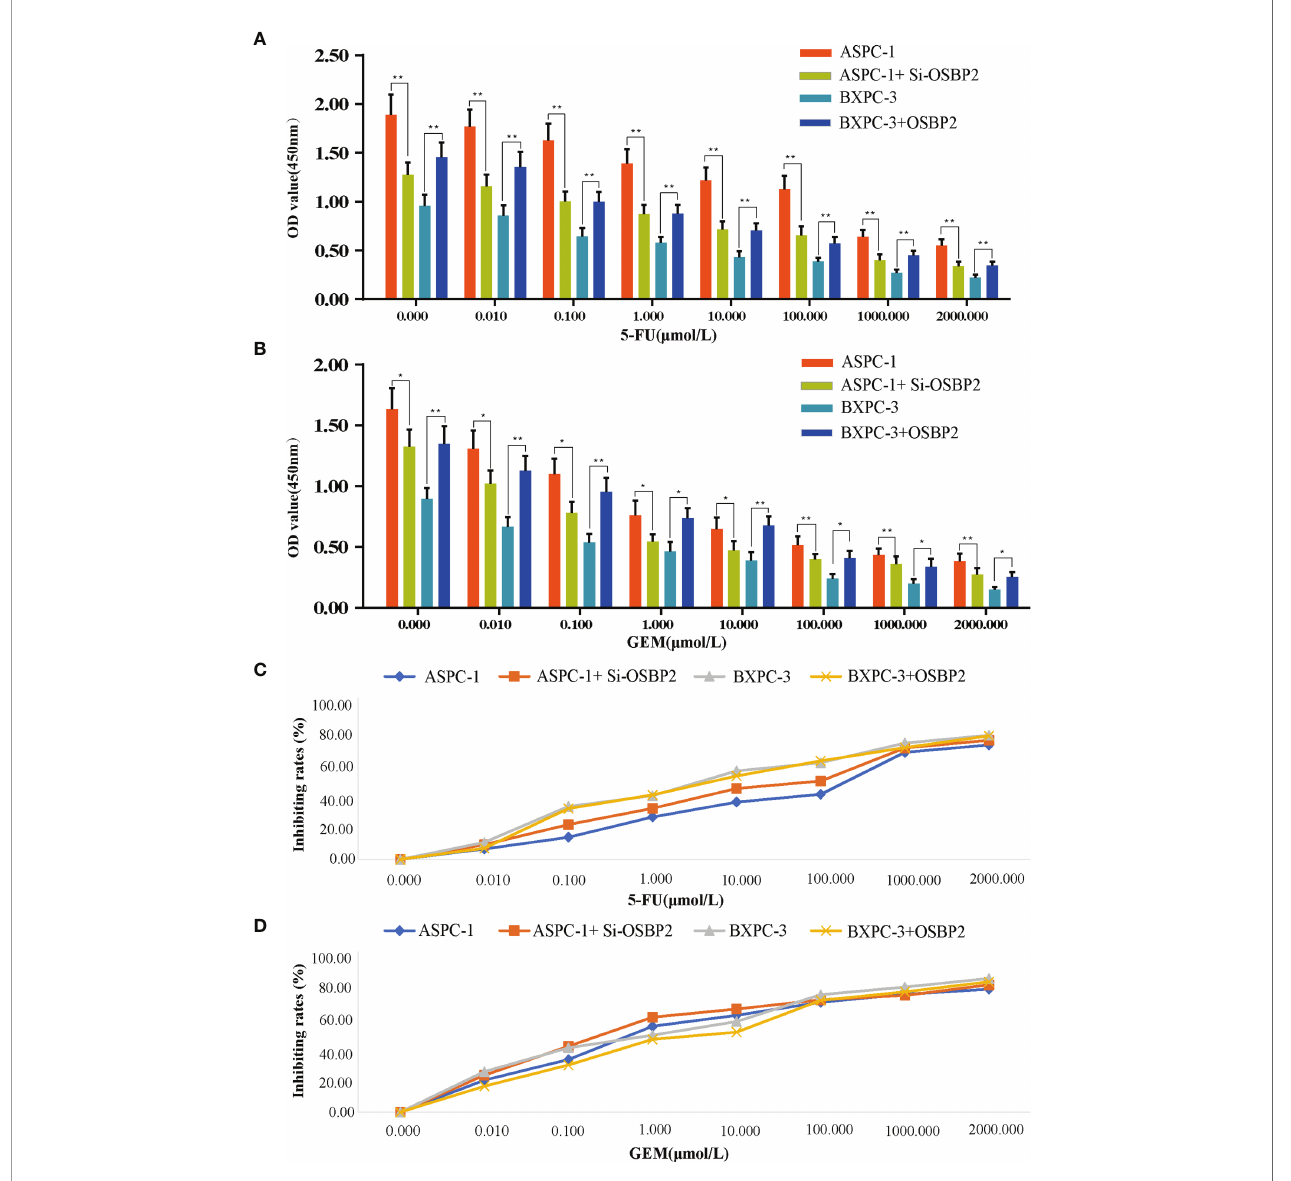
FIGURE 5 | Effect of OSBP2 on the resistance of PDAC cells to 5-FU and GEM. (A) Low OSBP2 expression decreased the resistance of ASPC-1 cells to 5-FU (P < 0.01), and OSBP2 overexpression increased the resistance of BXPC-3 cells to 5-FU (P < 0.01). (B) Low OSBP2 expression decreased the resistance of ASPC- 1 cells to GEM (P < 0.01), and OSBP2 overexpression increased the resistance of BXPC-3 cells to GEM (P < 0.01). (C, D) Increased concentrations of 5-Fu and GEM increased the inhibition of ASPC-1 and BXPC-3 cell lines. OSBP2, oxysterol-binding protein 2; 5-FU, 5- fl uorouracil; GEM, gemcitabine. *P < 0.05, **P <